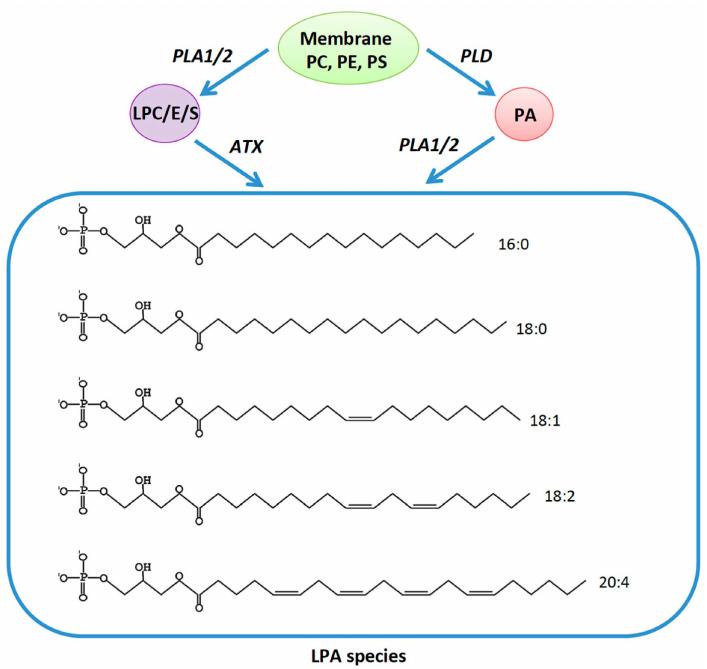
Figure 1. Biosynthesis of lysophosphatidic acid (LPA): The membrane phospholipids phosphatidyl choline (PC), phosphatidyl ethanolamine (PE) or phosphatidyl serine (PS) get converted into their corresponding lyso-forms by the action of phospholipase A1 and A2 (PLA1/2). Autotaxin (ATX) then generates different LPA species using the lyso-forms of membrane lipids. Alternatively, PC, PE or PS are catalyzed into phosphatidic acid (PA) by phospholipase D (PLD). PLA1/2 then acts on phosphatidic acid (PA) and form LPA. The structure of some common human LPAs is